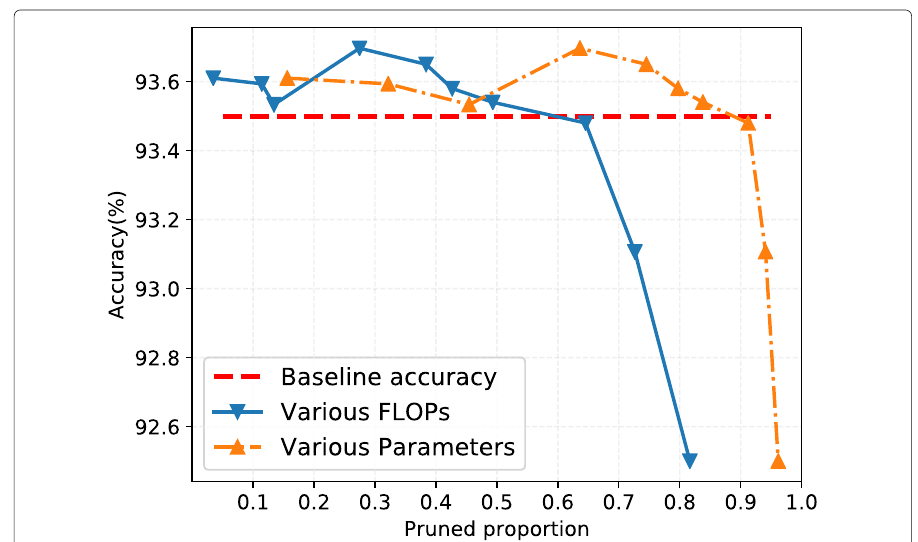
Fig. 7 The results are based on pruning VGG on CIFAR-10 with various pruned proportions in both FLOPs and parameters